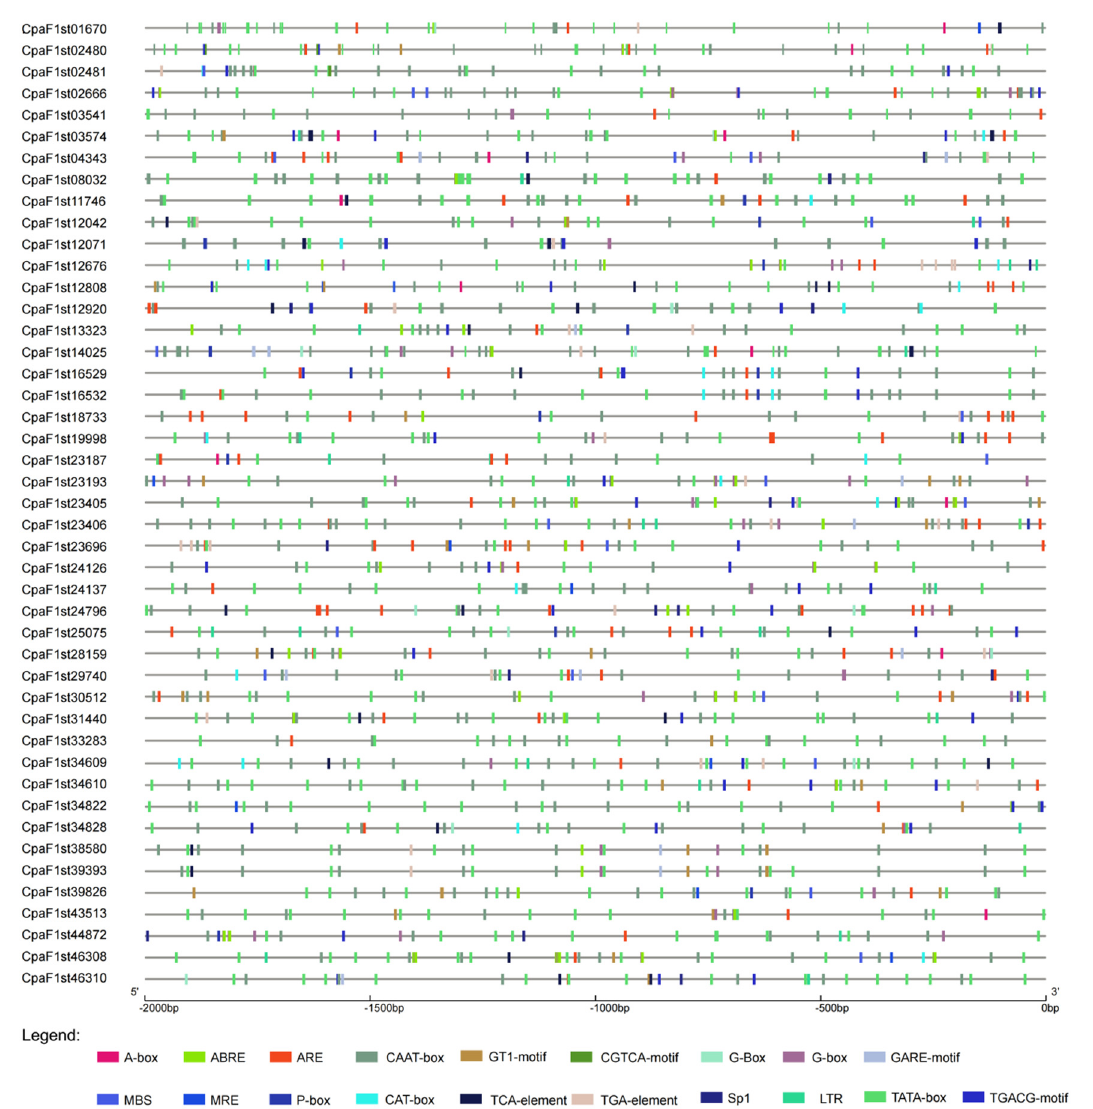
Figure 5. Cis-acting components of MIKC-type MADS-box genes in C. paliurus. All promoter sequences (2000 bp) were analyzed. The MADS-box genes are shown on the left. Scale bar at the base indicates length of promoter sequence. The functions of cis-acting element can be found in Table S1.